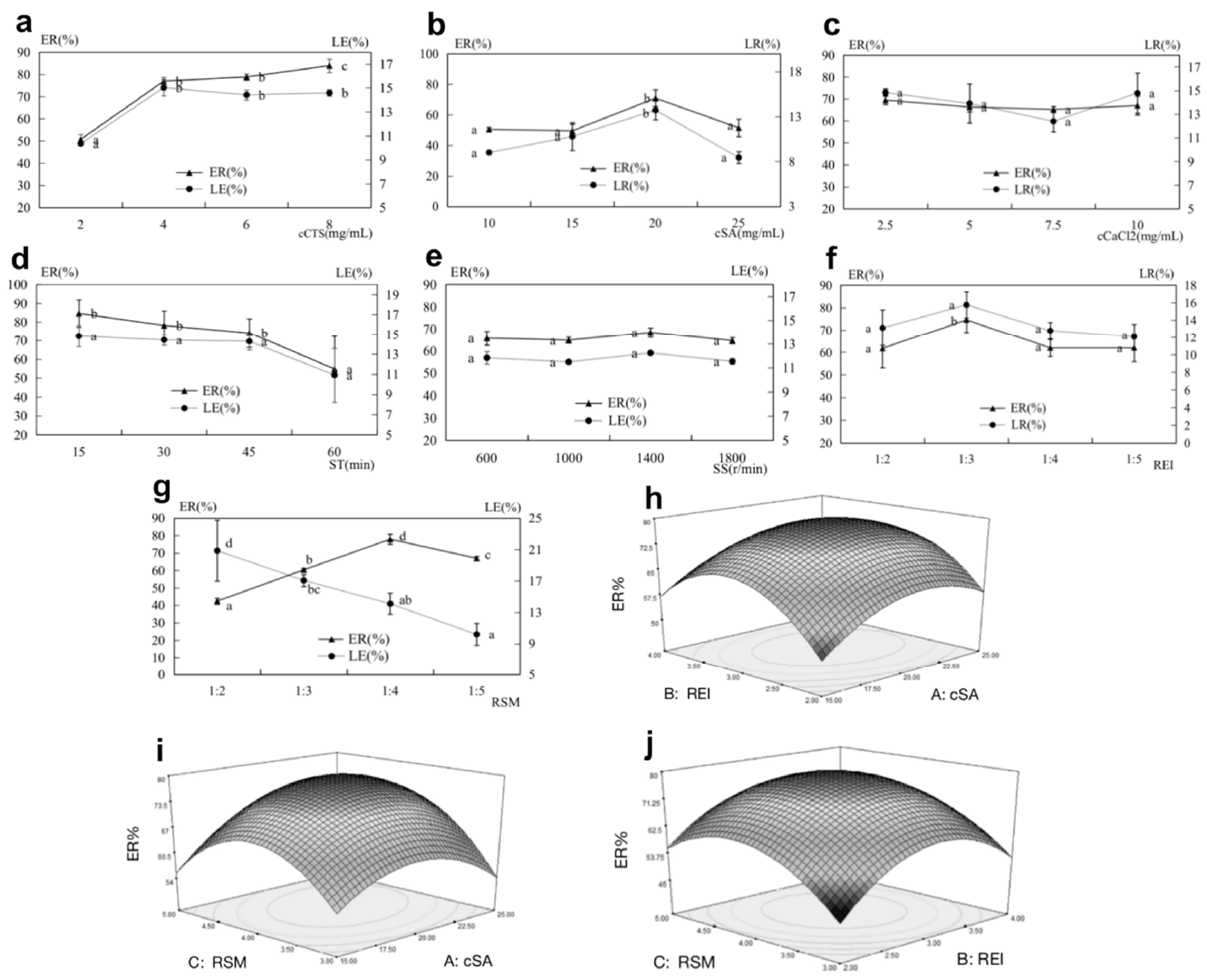
Figure 2. Factors affecting MGS capsule preparation. Effect of ( a ) cCTS; ( b ) cSA; ( c ) cCaCl 2 ; ( d ) ST; ( e ) SS; ( f ) REI; ( g ) RSM on the encapsulation rate (ER) and loading efficiency (LE); three-dimensional surface plots showing the effect of varying components ( h ) cSA; ( i ) REI; ( j ) RSM on ER; a,b,c,d, ab, and bc in the line chart means the difference of significance among the groups.